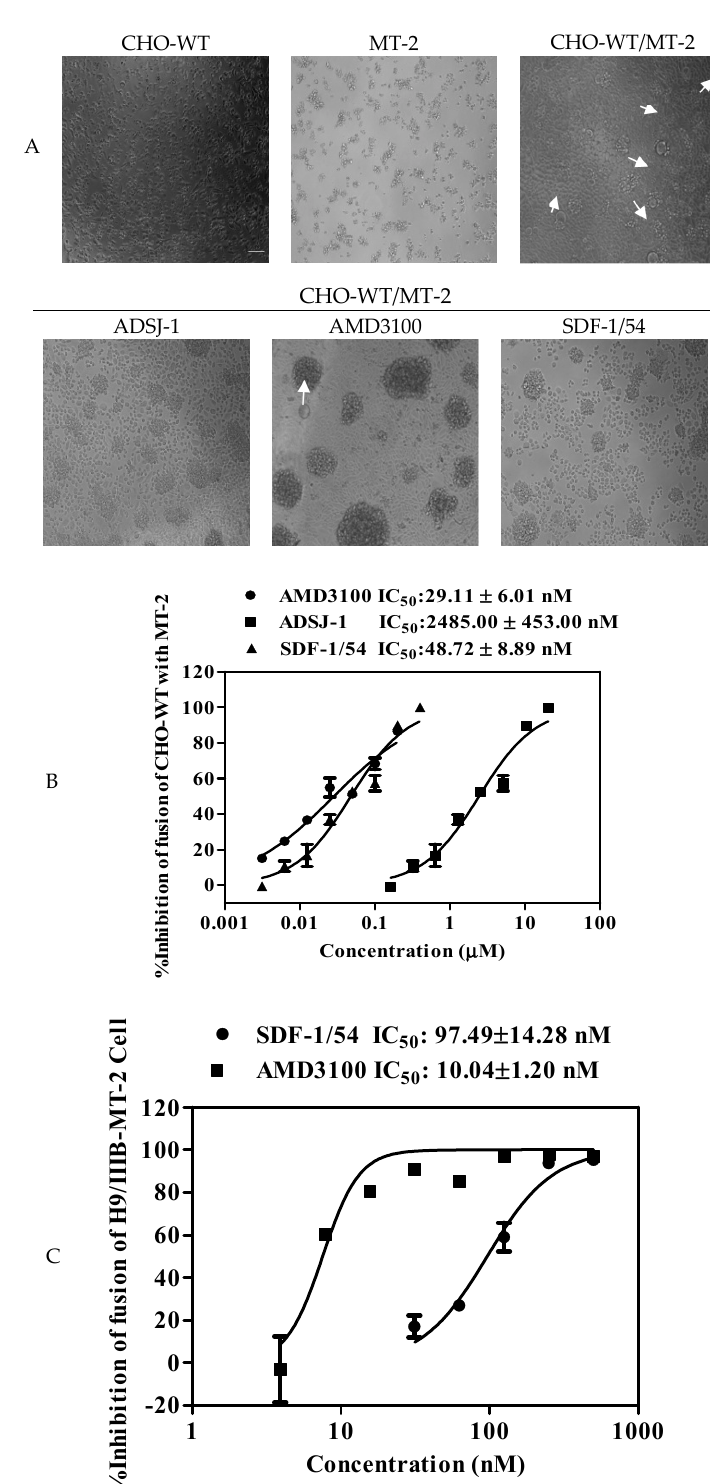
Figure 6. The inhibitory activity of SDF-1 / 54 against HIV-1-mediated cell–cell fusion. E ff ects of SDF-1 / 54 on the formation of syncytium with CHO-WT and MT-2 cells ( A ). Among them, the white arrow in the figure indicates the fusion bubble of cell fusion. Scale bar = 100 µ m. ( B ) Dose-response curves and IC 50 values of SDF-1 / 54 inhibiting cell–cell fusion. ADS-J1 was chosen as a positive control. ( C ) Cell–cell fusion between calcein-labeled H9 / HIV-1 IIIB and MT-2 cells. Data are presented as mean ± SD.